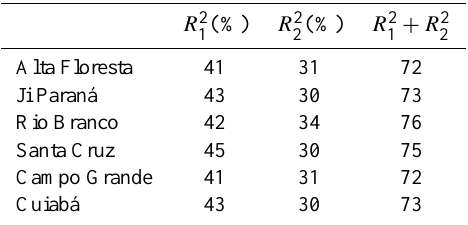
vector is that stronger large-scale upward motion and moister mid-level atmosphere are associated with larger amounts of rainfall. For a moister mid-level environment, the entrain- ment into the cloud generates less evaporation, thus poten- tially affecting the rainfall